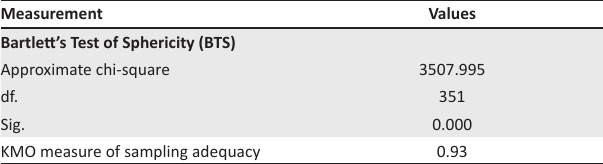
TABLE 1: Summary of Kaiser–Meyer–Olkin and Bartlett’s Test of Sphericity on the factorability of the 25-item measure for the Redeemer’s University Suicidality